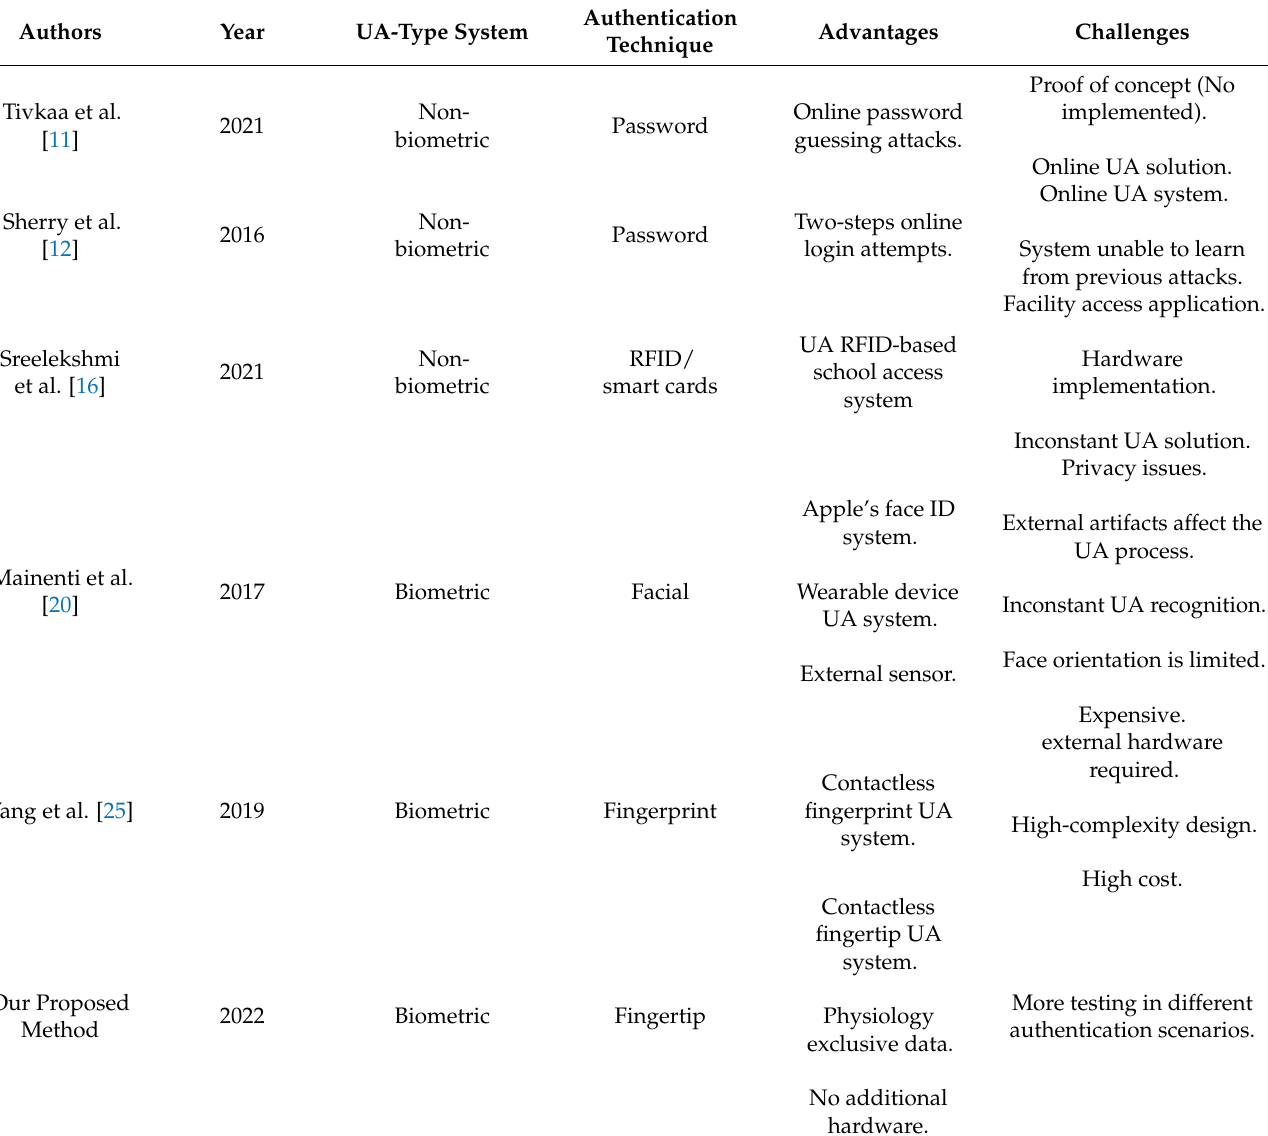
Table 9. Comparison of various UA methods in non-biometric and biometric